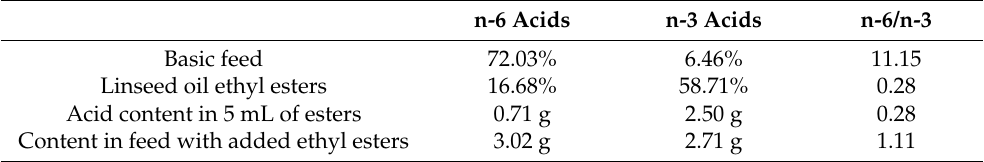
Table 3. Average content of omega-6 and omega-3 acids acids and n-6/n-3 ratio in feed and esters and the ratio of these